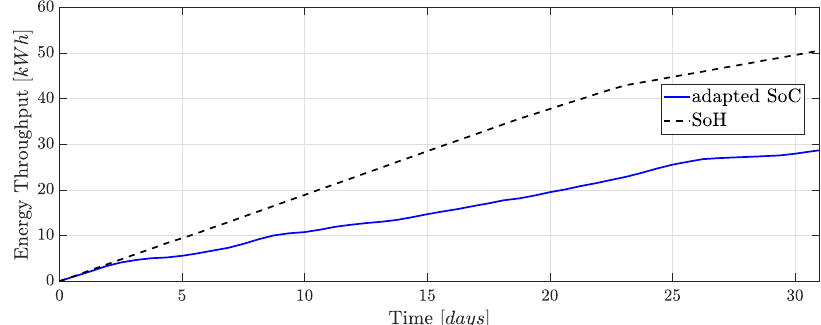
Figure 28. Energy Throughput: Case 2.